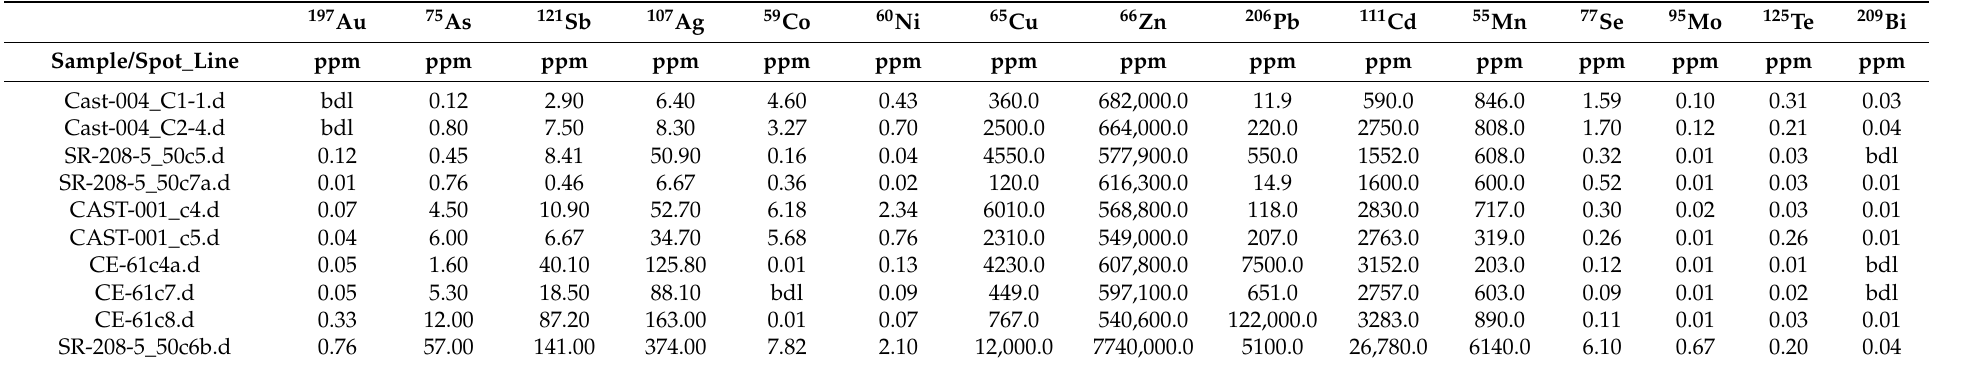
Table A3. Gold and other trace element contents in sphalerite obtained by LA-ICP-MS.